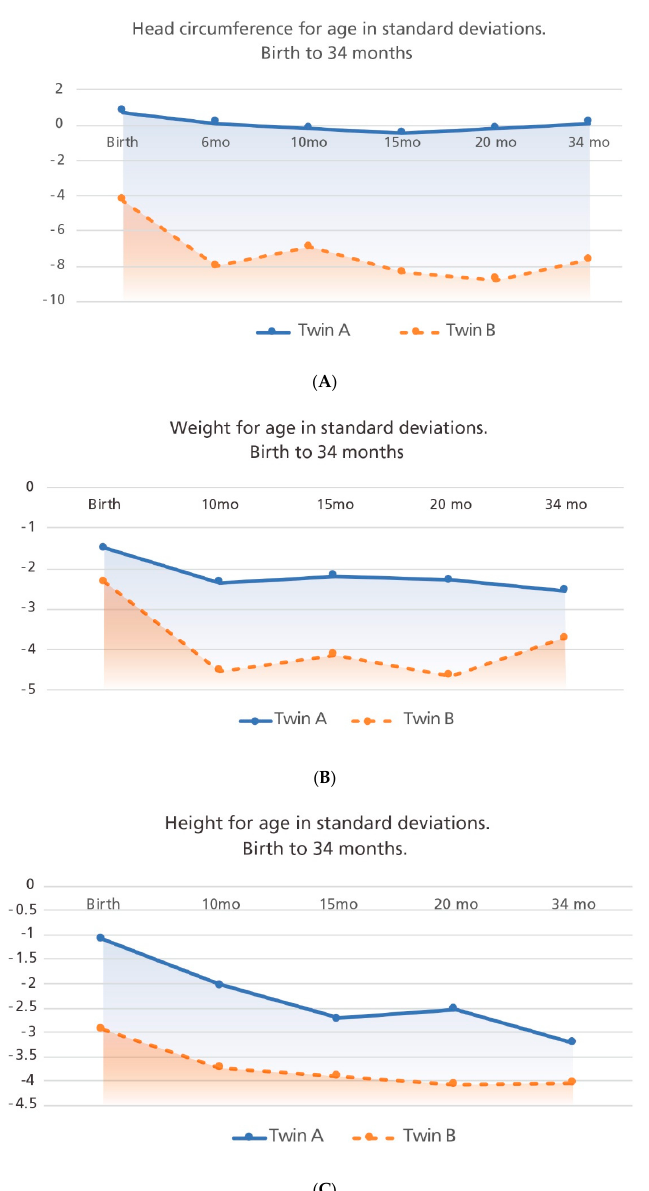
Figure 2. Growth trajectories for both twins taken at five time-points are shown. Panel A : head circumference for age, Panel B : weight for age and Panel C : height for age. Birth measurements were analyzed with Intergrowth 21st newborn growth standards comparing the measurement with gestational age (GA) and sex; other measurements were analyzed with the World Health Organization (WHO) growth standards comparing measurements with chronological age and